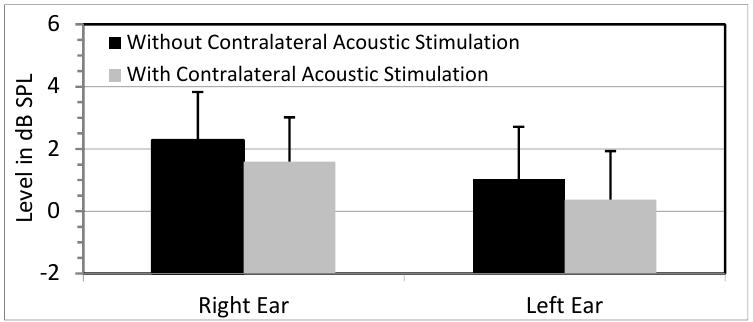
Figure 1. Mean overall amplitudes of click-evoked otoacoustic emissions (OAEs) for the two conditions: (1) without contralateral acoustic stimulation (CAS) and (2) with CAS in the two ears. Error bars indicate standard errors.